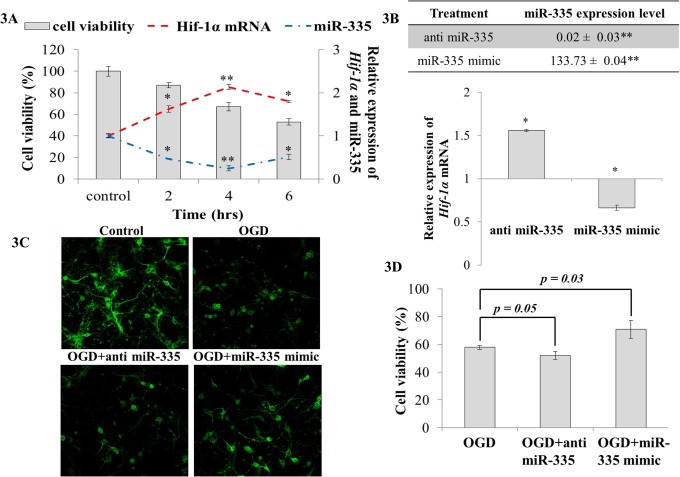
Cell viability and Hif-1α expression in primary neuronal culture transfected with anti miR-335 or miR-335 mimic during reperfusion following OGD.
(A)
Hif-1α was significantly upregulated upon OGD while miR-335 on the other hand demonstrated a significant downregulation in which both showed maximum changes at 4 hrs OGD. The primary y-axis denotes cell viability whereas the secondary y-axis indicates relative expression of Hif-1α and miR-335; (B) miR-335 expression significantly increased in the presence of miR-335 mimic (p < 0.01) and significantly decreased when cells were transfected with anti miR-335 (p < 0.01) during reperfusion. Cells transfected with miR-335 mimic during reperfusion after OGD showed significantly decreased Hif-1α expression compared to cells subjected to OGD and transfected with vehicle; (C) Neurons subjected to OGD displayed increased apoptosis and degenerated neuritis. Cells transfected with miR-335 mimic after OGD showed increased cell survival and maintenance of neurites as compared to cells subjected to OGD. (D) Cells transfected with miR-335 mimic demonstrated significantly reduced cell death compared to cells subjected to OGD and transfected with vehicle (p < 0.05). Relative expression (2-ΔΔCt) was calculated based on vehicle transfected controls as calibrator and 18S as endogenous control. * p value < 0.05; ** p value < 0.01.